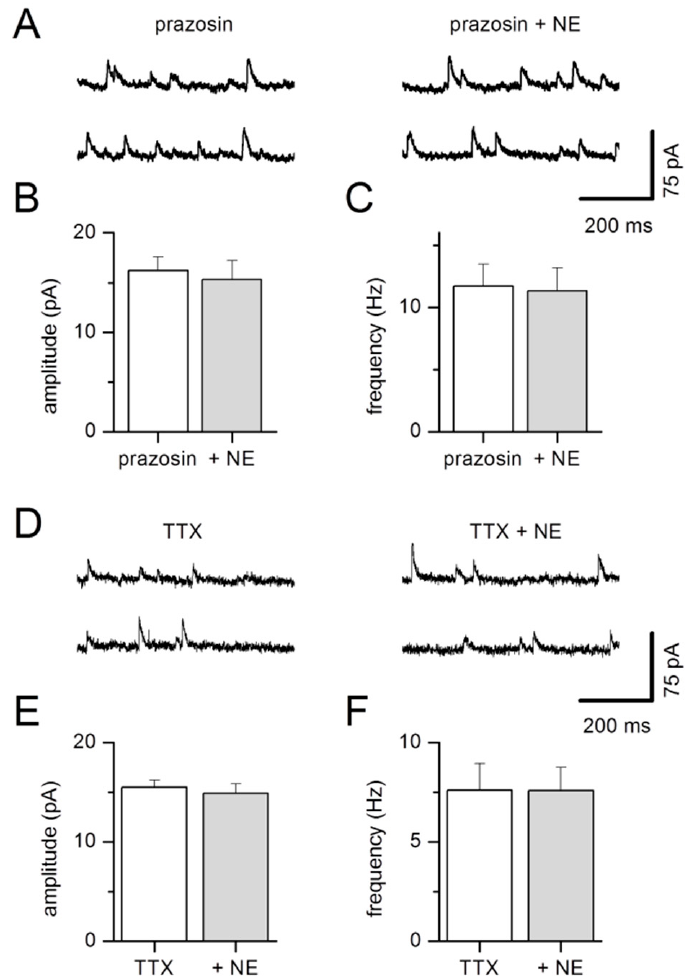
Figure 7. NE e ff ects on GABA-mediated synaptic activity are blocked by the α 1-adrenergic antagonist prazosin ( A – C ) or in the presence of TTX ( D – F ). ( A ) Examples of sIPSCs recorded in an individual LA projection neuron before (left) and during application of NE in the continuous presence of prazosin (right). ( B ) sIPSC amplitude and ( C ) frequency pooled during control conditions and after addition of NE are not increased in the presence of prazosin, n = 7 neurons from 6 animals. ( D ) Examples of mIPSCs recorded in an individual projection neuron before (left) and during application of NE in the continuous presence of TTX (right). No e ff ect of NE was detected on mean mIPSC amplitudes ( E ) and mean mIPSC frequencies ( F ) between control conditions (TTX) and after addition of NE (TTX + NE), n = 8 neurons from 6 animals.